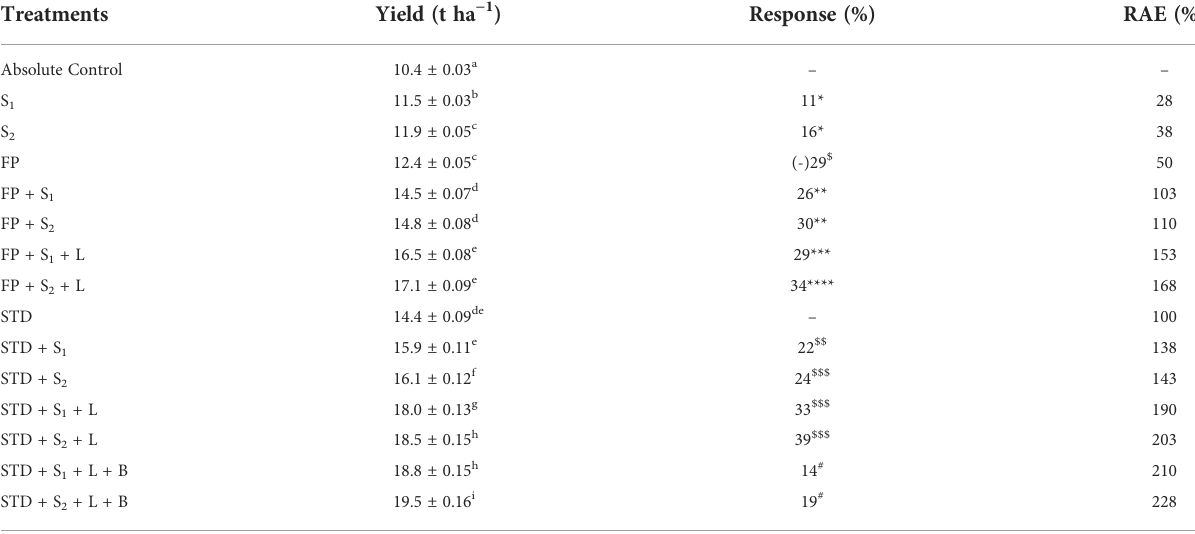
TABLE 5 Effect of native Rhizobium strains with different nutrient management practices on yield and relative agronomic ef fi ciency of French